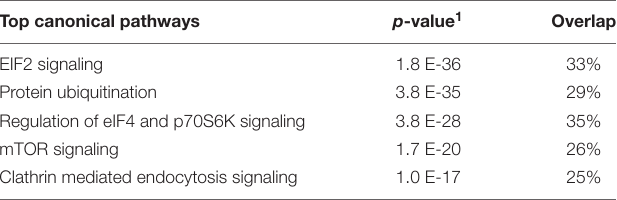
TABLE 1 | Canonical pathway analysis of primary human trophoblast (PHT) secretome by Ingenuity Pathway Analysis (IPA). Top canonical pathways p -value 1 Overlap EIF2